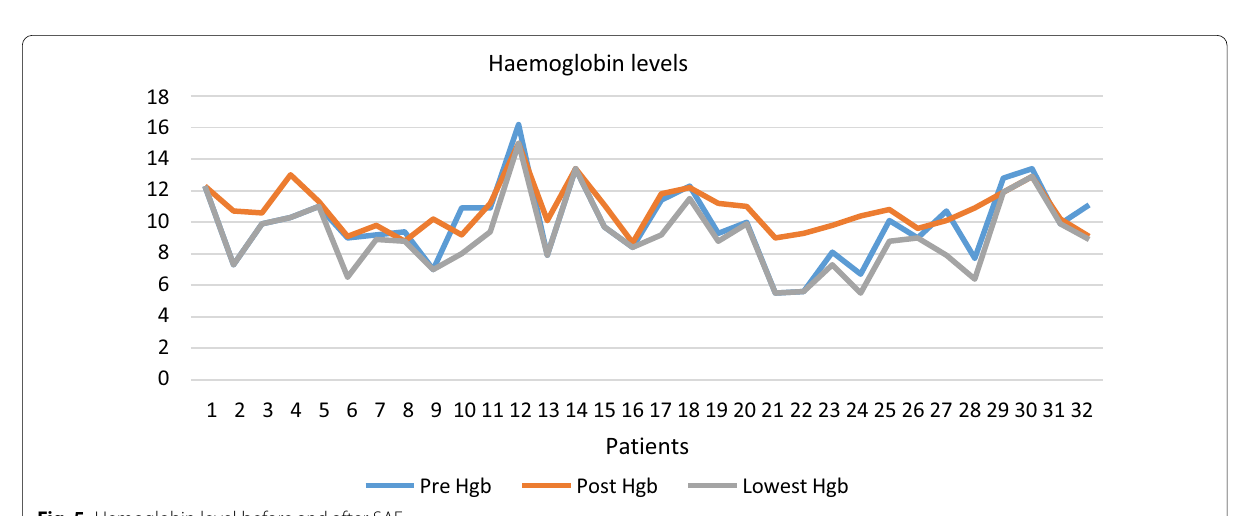
Fig. 5 Hemoglobin level before and after